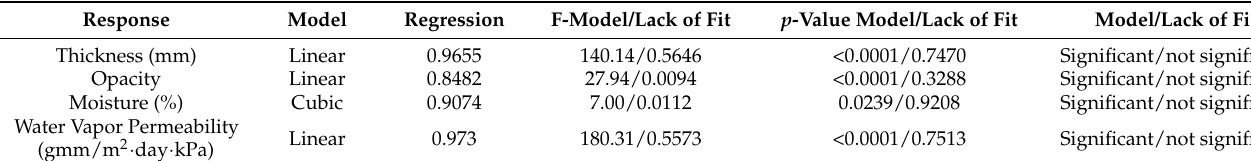
Table 2. Analysis of variance using ANOVA.